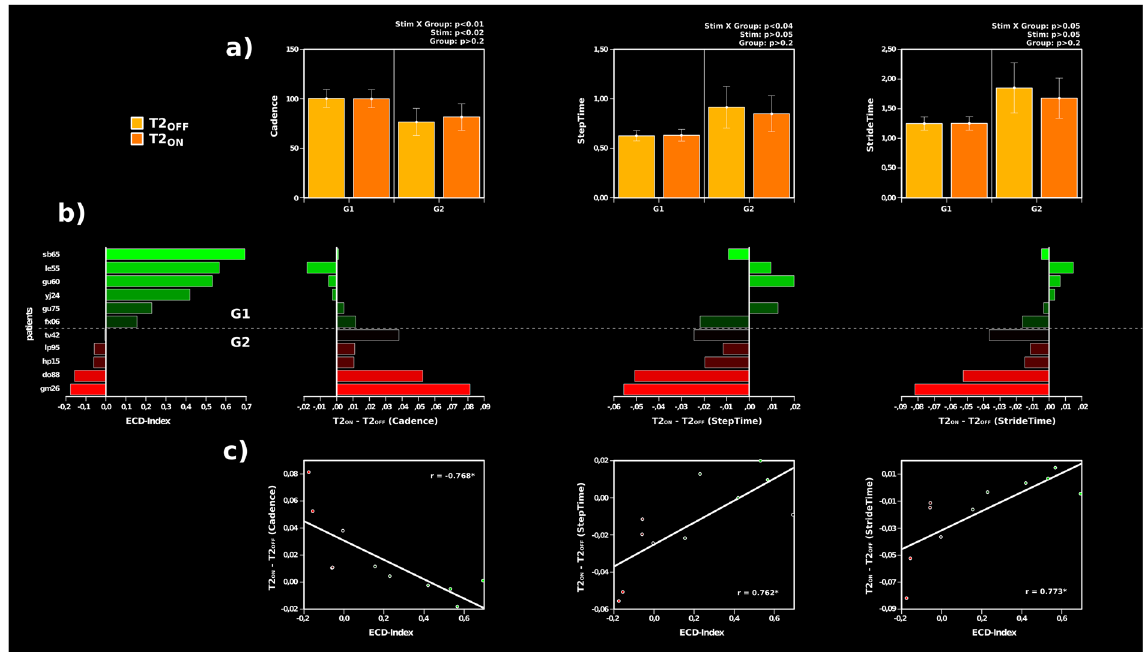
Figure 4. Gait and localization. Correlation between gait performance and laterality of cortical plasticity. ( a ) For G1 the gait performance did not decline, once the stimulator was turned off. However gait performance droped without active stimulation in G2. ( b ) This decline was highly correlated with a larger dipole displacement in the contralesional hemisphere. The vertical barplots show the ECD-Index and relative gait performance at T2 for each single patient. ( c ) The scatterplots display the relation between the ECD-Index and the change in gait performance at